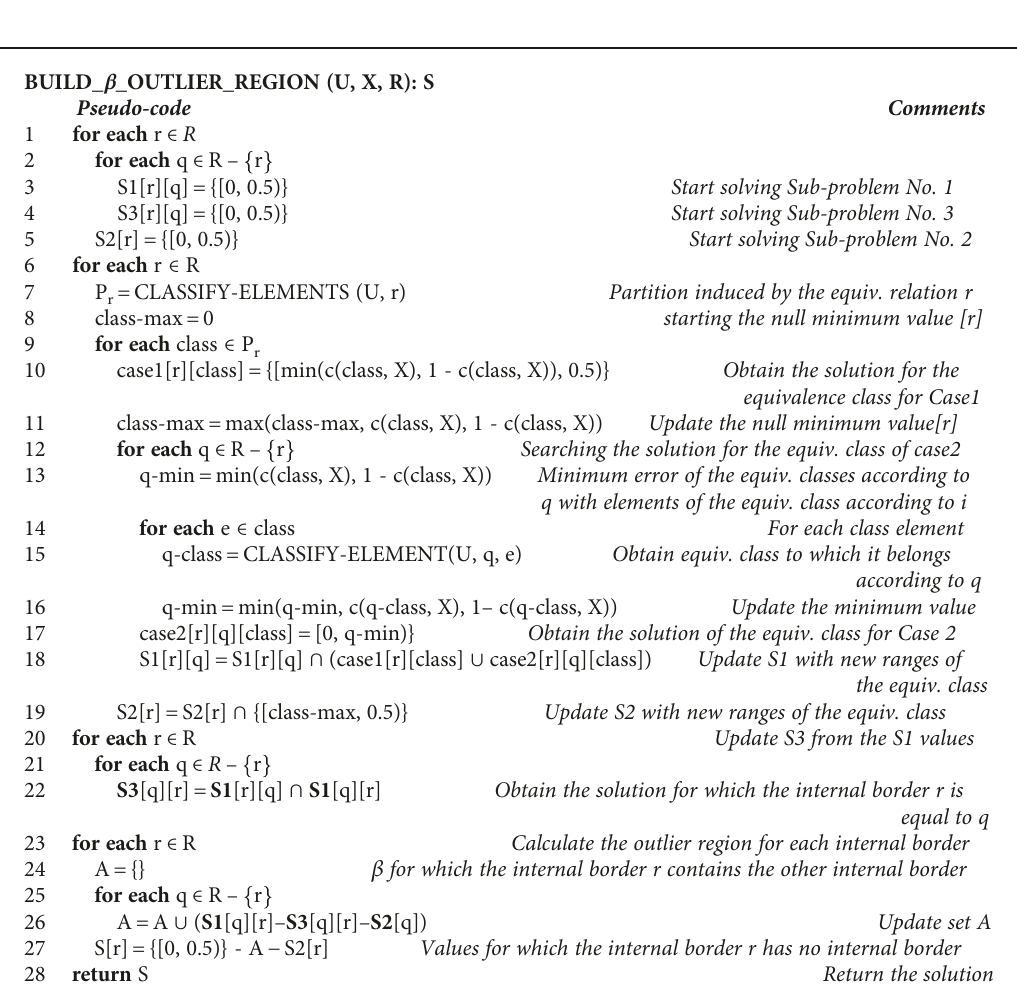
Algorithm 1: Pseudo-code of the BUILD_ β _OUTLIER_REGION algorithm.